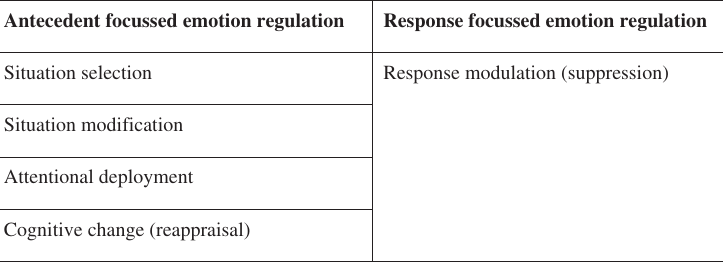
Figure 6. Gross Model of Emotion